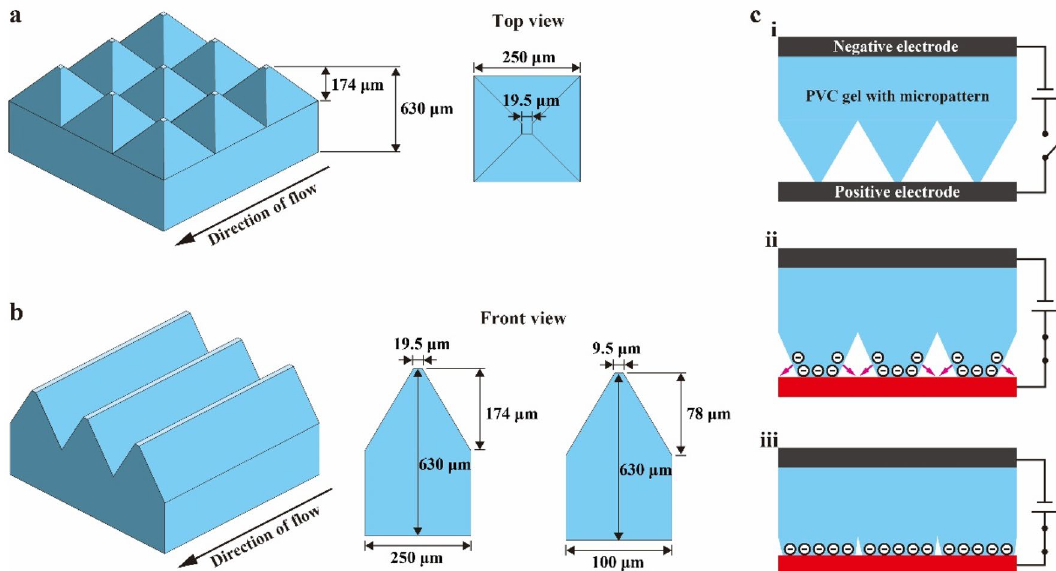
Figure 3. Geometry of the PVC gel sheets used in the pump. ( a ) Sheet with pyramid micropattern. ( b ) Sheet with ridge micropattern. ( c ) Actuation mechanism of a PVC gel sheet with micropattern. (i) The gel is sandwiched between positive and negative rigid electrodes. (ii) When a voltage is applied, the gel is deformed in a manner which flattens the vertices. (iii) The gel reaches an equilibrium state, where the entire structure exhibits a displacement change in the thickness